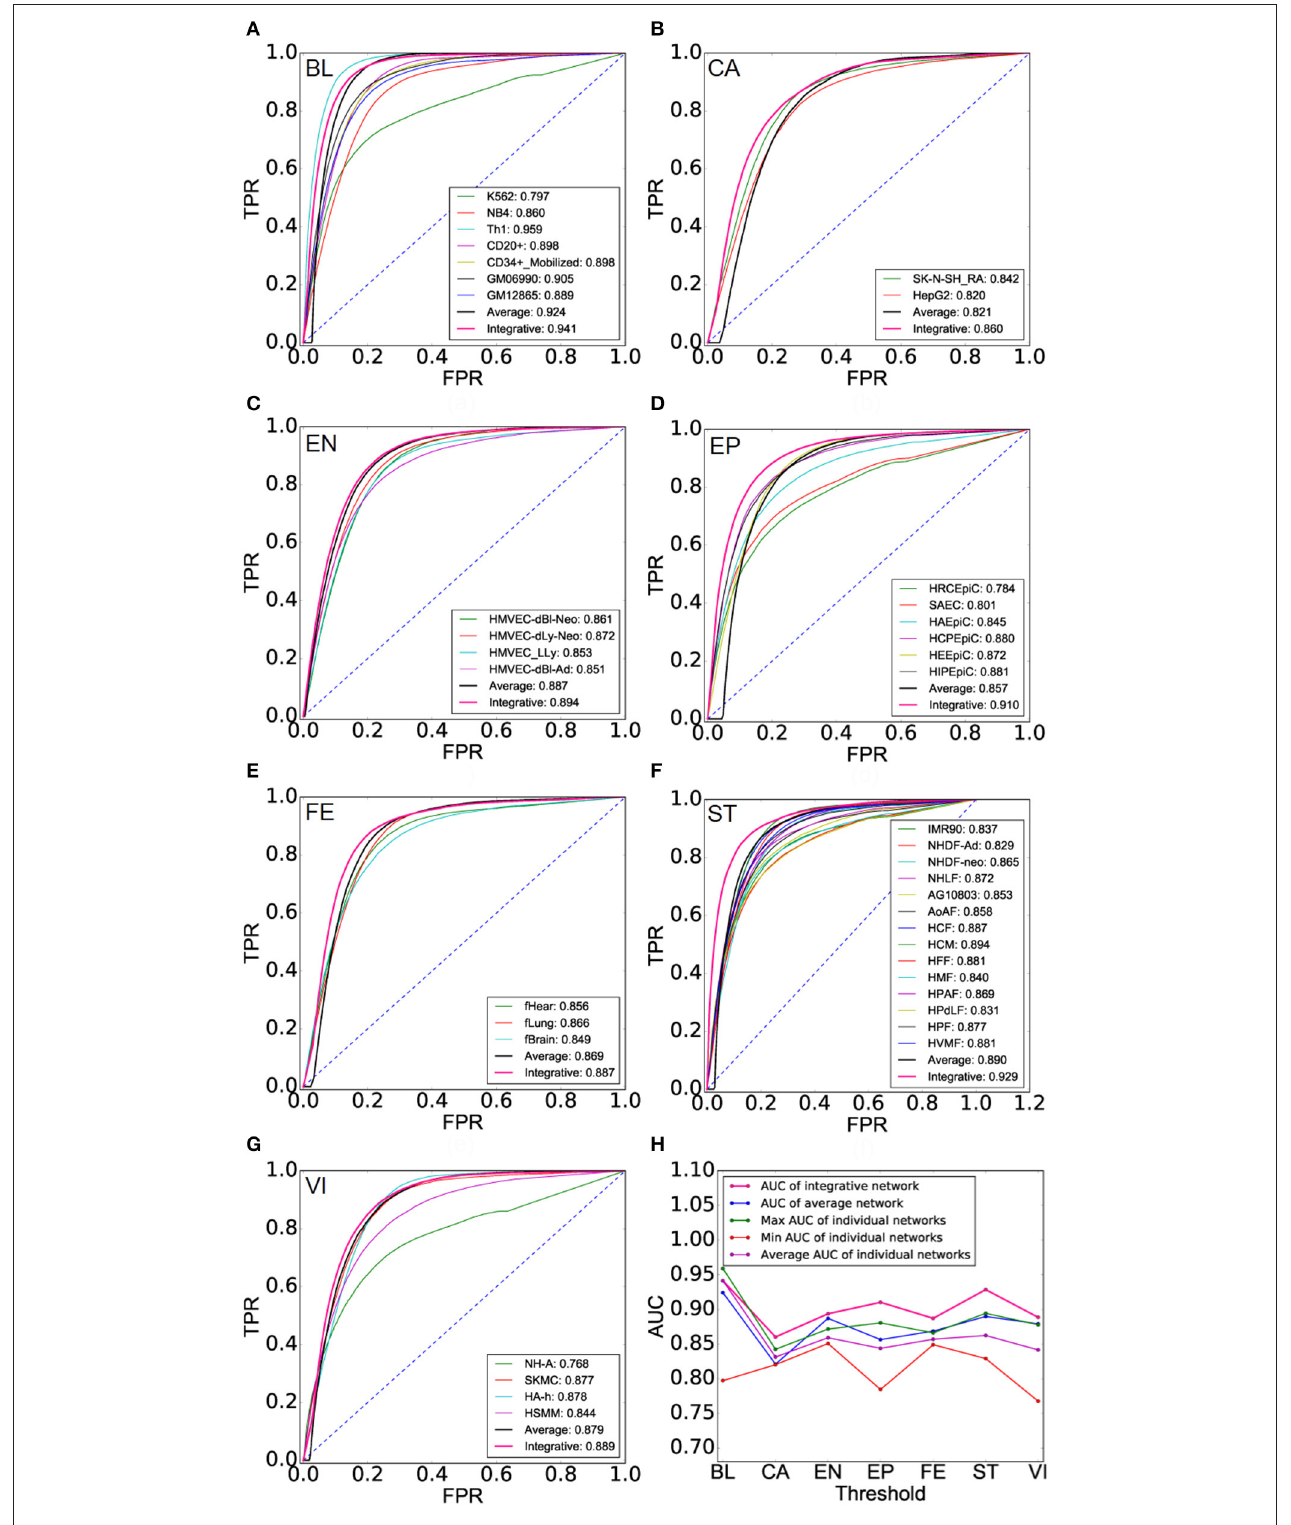
FIGURE 4 | Performance evaluation of cell lineage TF interaction networks. (A–G) ROCs of cell lineage networks (CL-Nets), average-integrative-networks (AI-Nets), and cell type TF interaction networks (CT-Nets) of the corresponding cell lineage across all seven cell lineages. (H) AUC of CL-Nets, AI-Nets as well as the maximum, minimum and average AUC of CT-Nets in the same cell lineage across all seven cell